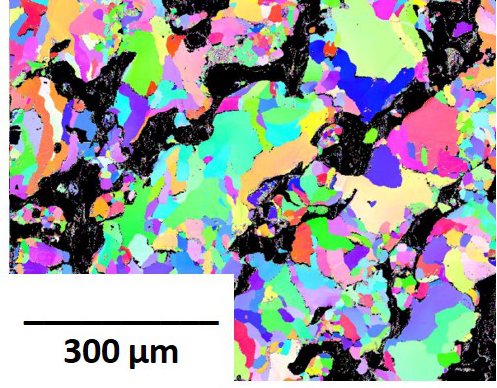
Figure 5. EBSD map of the top surface of the pure molybdenum specimen printed at 100